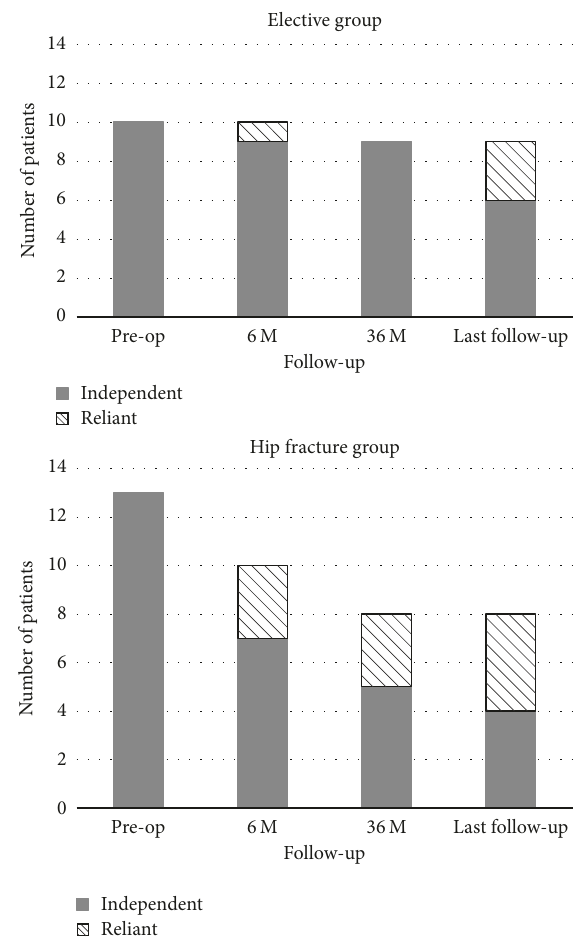
Figure 3: Distribution of independent and reliant patients in the elective and hip fracture groups during